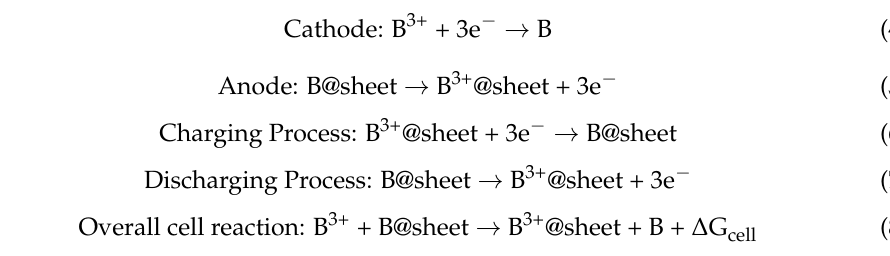
Table 2. The overall cell energy change ( ∆ E cell ) and the cell voltages of the graphene sheet(s). B 3+